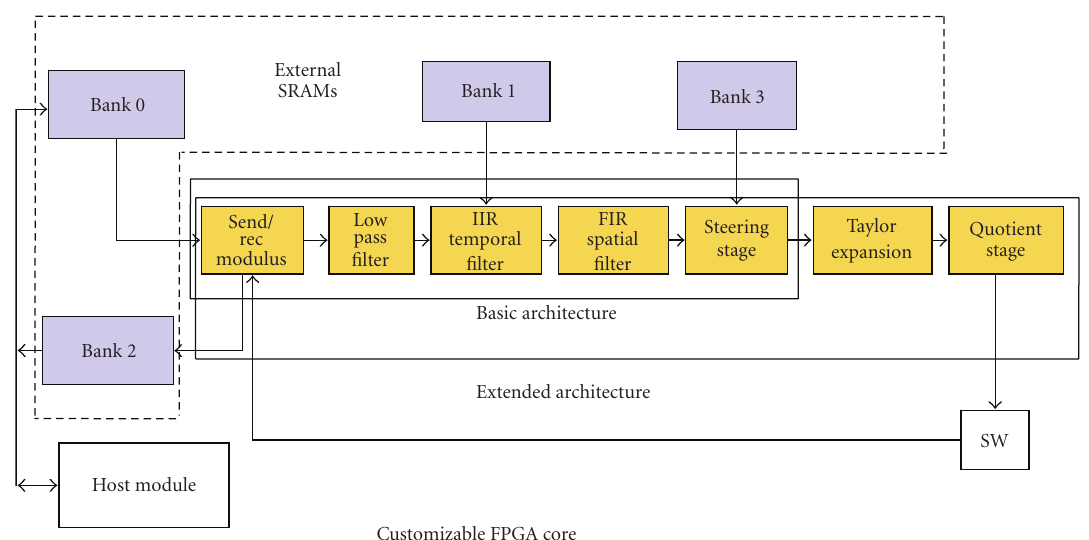
Figure 4: Scheme of the two architectures working with an asynchronous pipeline.